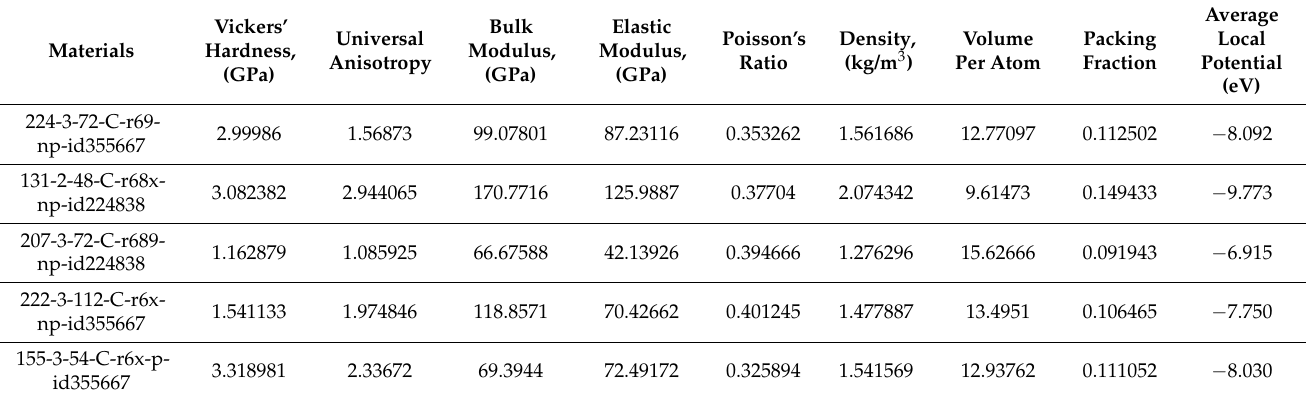
Table 3. Carbon allotropes with low Vickers’ hardness with other material